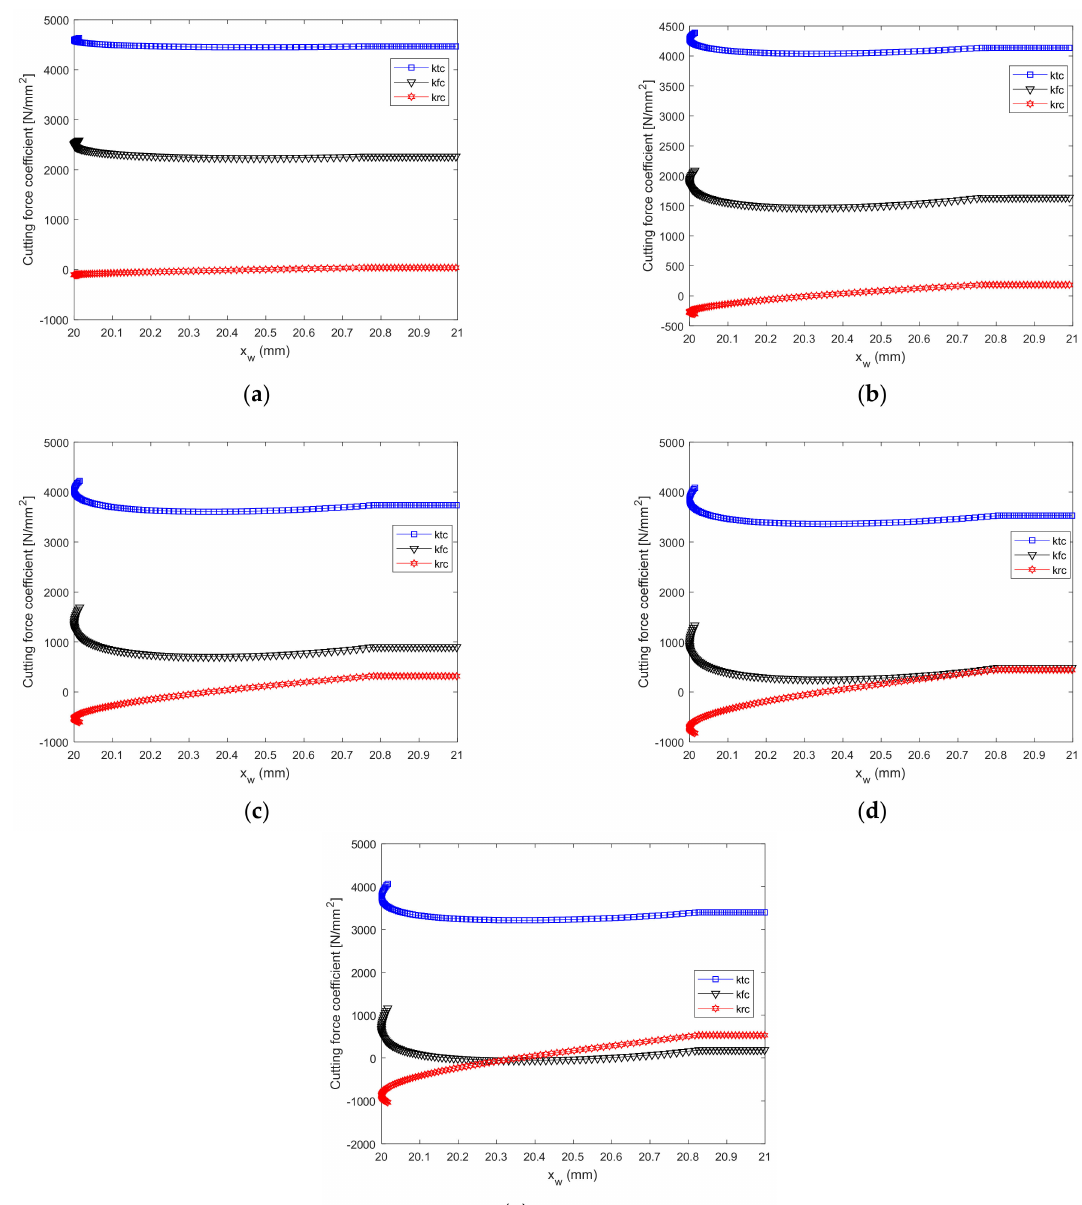
Figure 9. Cutting force coefficients for Test Nos. ( a ) 1; ( b ) 2; ( c ) 3; ( d ) 4; ( e )